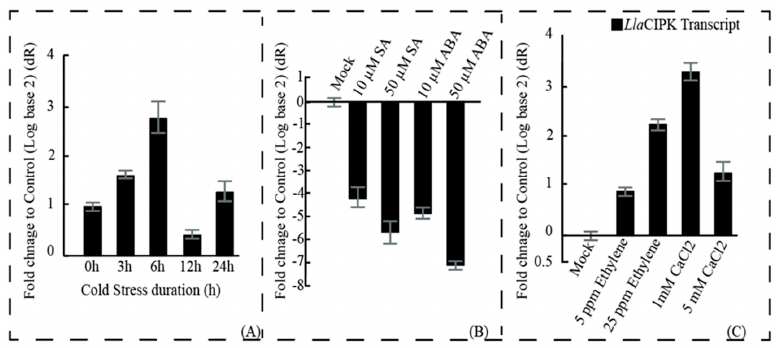
Figure 4. Analysis of Lla CIPK expression profiles in Lepidium seedlings subjected to different treatments: ( A ) The Lepidium seedlings were subjected to cold stress (4 °C) for the indicated times (0, 3, 6, 12 and 24 h), ( B ) The seedlings were sprayed with different concentrations of SA and ABA solution. ( C ) The seedlings were sprayed with different concentrations of Ethylene and CaCl 2 solution. The expression level of Lla CIPK at 0 h or in mock treatments was used as control (calibrator). Relative transcript abundance was calculated using the comparative 2 - ΔΔ CT (cycle threshold) method. Error bars represent standard error of means based on three independent biological replicates.